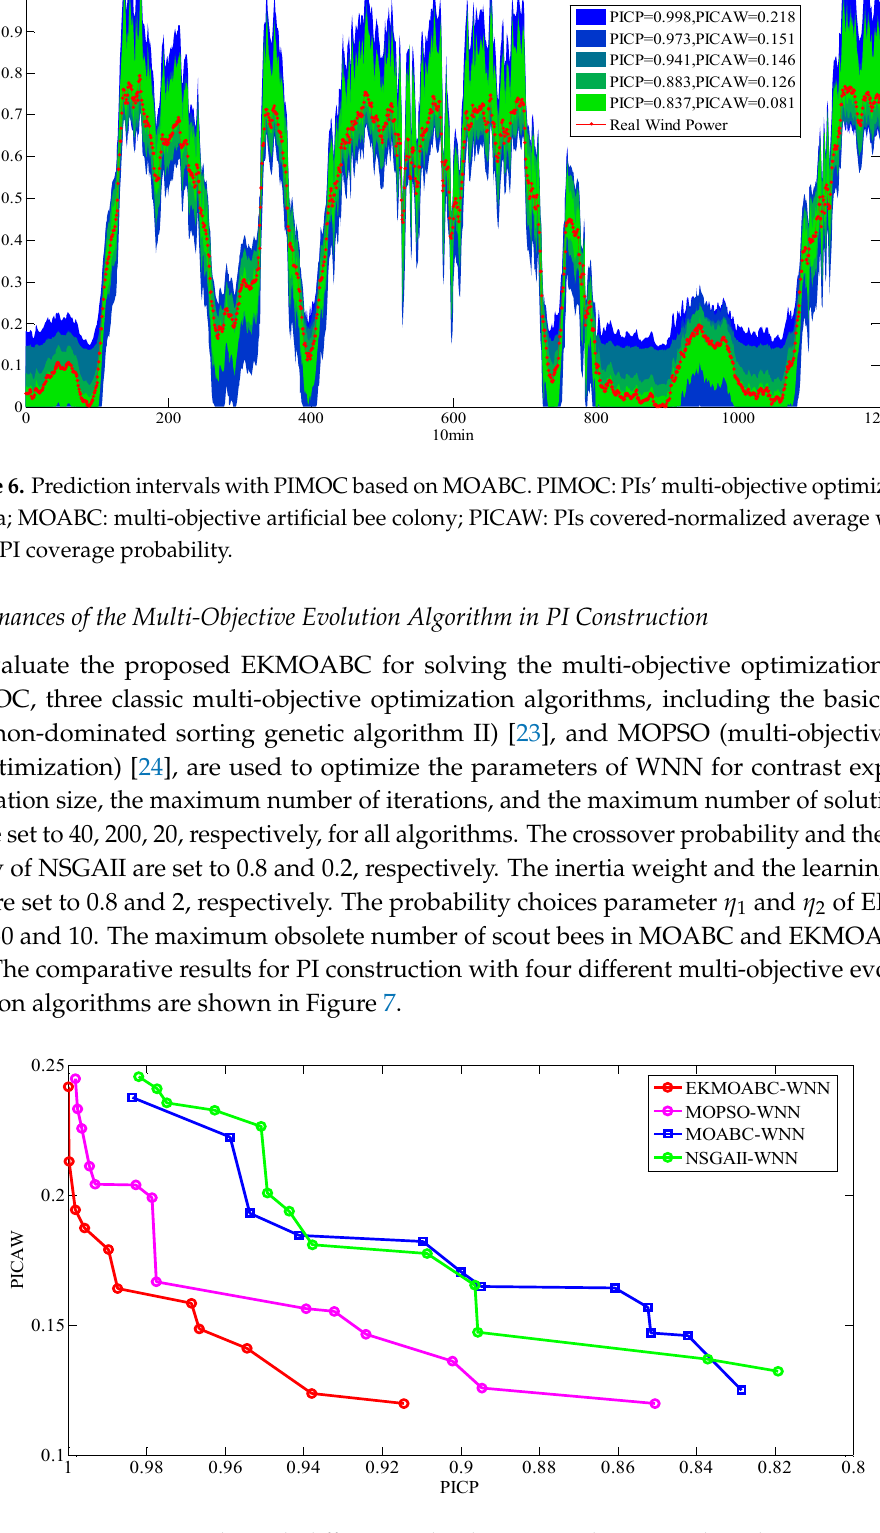
Figure 7. Comparative results with different multi-objective evolutionary algorithms. EKMOABC: evolutionary knowledge multi-objective artificial bee colony; MOPSO: multi-objective particle swarm optimization; MOABC: multi-objective artificial bee colony; NSGAII: non-dominated sorting genetic algorithm II; PICAW: PIs covered-normalized average width; PICP: PI coverage probability.